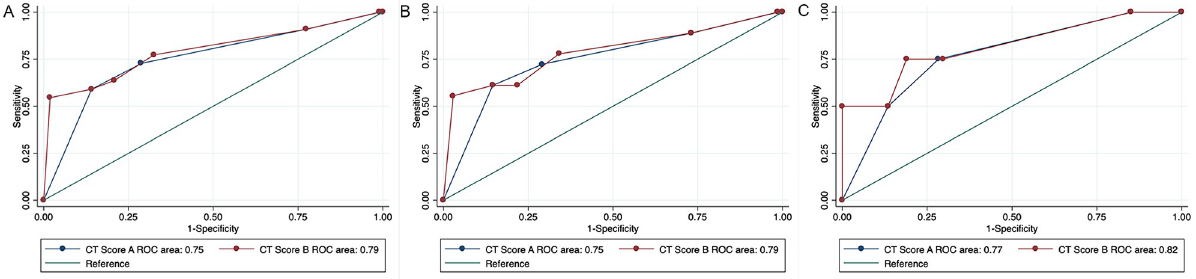
Fig 2. Receiver operator characteristic (ROC) curves illustrate the diagnostic ability of CT composite scores for the prediction of cervical lymph node metastasis in dogs with oral tumors. CT score A, consisting of lymph node (LN) size, shape and contrast pattern scores, was inferior to CT score B, which included CT Score A features with a subjective metastasis score. CT score B was significantly superior for the prediction of metastasis when all LN were categorized together ( A ; P = 0.0005)) and when MLN ( B ; P = 0.05) or MRLN ( C ; P = 0.03) were evaluated separately.